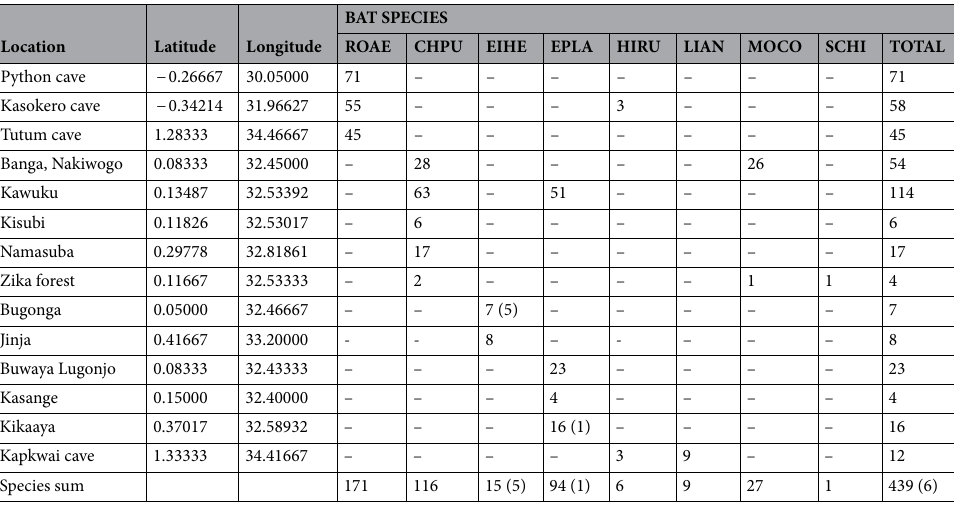
Table 1. All bat species and trap sites collected from 2009 to 2013 18,26 . Numbers in parentheses (for samples from Bugonga and Kikaaya) indicate the number of individuals from which both spleen and liver were collected and analyzed separately (n = 6). Owing to some bats having two organs sampled, we tested a total of 445 samples from 439 bats. (Species codes as follows: ROAE = Rousettus aegyptiacus , CHPU = Chaerephon pumila , EIHE = Eidolon helvum , EPLA = Epomophorus labiatus , HIRU = Hipposideros ruber , LIAN = Lissonycteris angolensis , MOCO = Mops condylura , SCHI = Scotoecus hindei